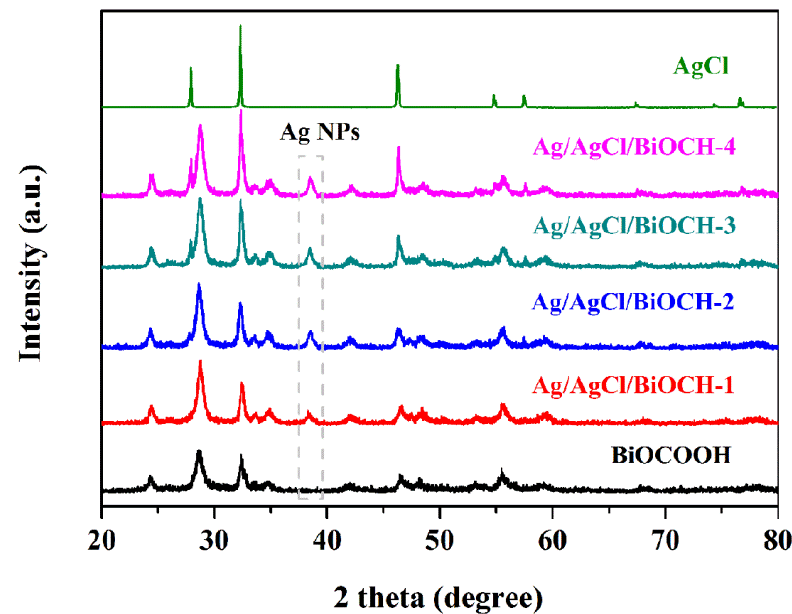
Figure 1. XRD patterns of BiOCOOH, AgCl, and Ag/AgCl/BiOCOOH heterojunctions (Ag/AgCl/BiOCH-1, Ag/AgCl/BiOCH-2, Ag/AgCl/BiOCH-3, and